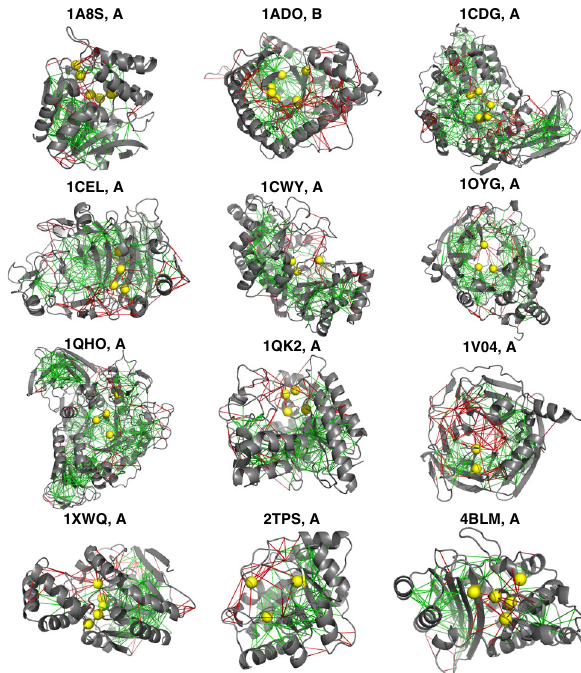
Fig. 3 Gallery of the localized frustration and highly frustrated networks in enzymatic proteins. The protein backbone is displayed as cartoons, the interresidue interactions with solid lines. Minimally frustrated interactions are shown in green, highly frustrated interactions in red, neutral contacts are not drawn. The catalytic sites are identi fi ed from the database and shown in yellow